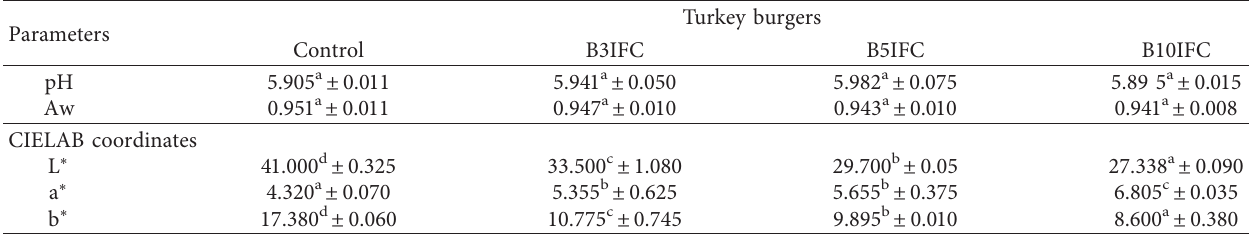
Table 5: Aw, pH, and color parameters of raw turkey burgers formulated with IFC 24h after conservation at 4 ° C.